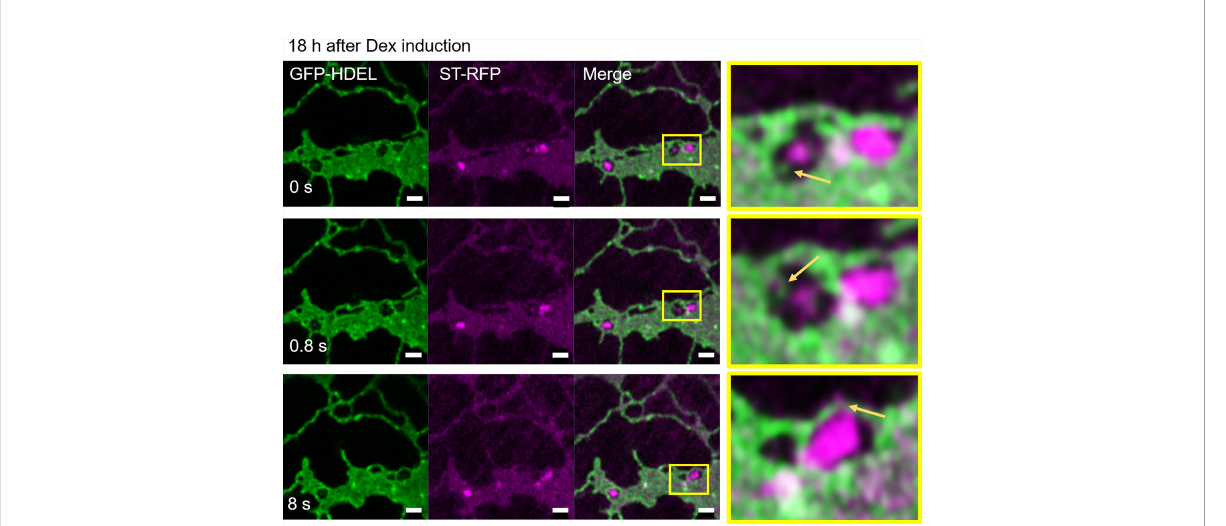
FIGURE 11 Disruption of Golgi membranes by inhibition of COPII uncoating leads to a segregation of ERGo tubules from Golgi remnants. The dominant negative mutant Sar1a-GTP is expressed in an inducible manner together with the ER and Golgi markers GFP-HDEL (green) and ST-mRFP (magenta). Imaging was carried out 18 h after dexamethasone (Dex) induction and a time-lapse (0 s, 0.8 s, 8 s) is shown. The yellow boxes in the images indicate areas shown in higher magni fi cation on the right hand side. ERGo tubules and Golgi protrusions are indicated with yellow arrows. Size bars = 1